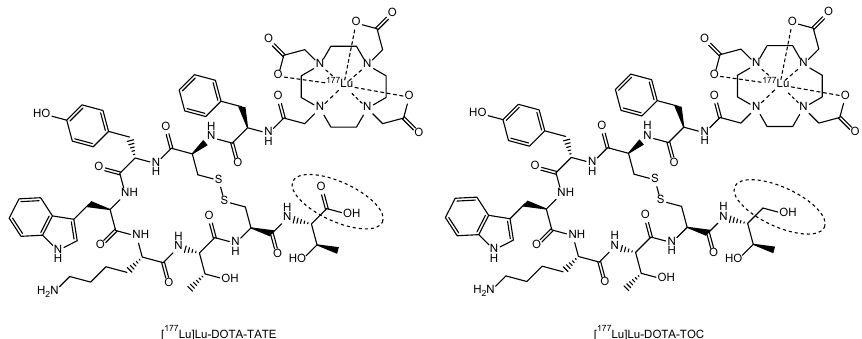
Fig. 2 Molecular structures of [ 177 Lu]Lu-DOTA-TATE and [ 177